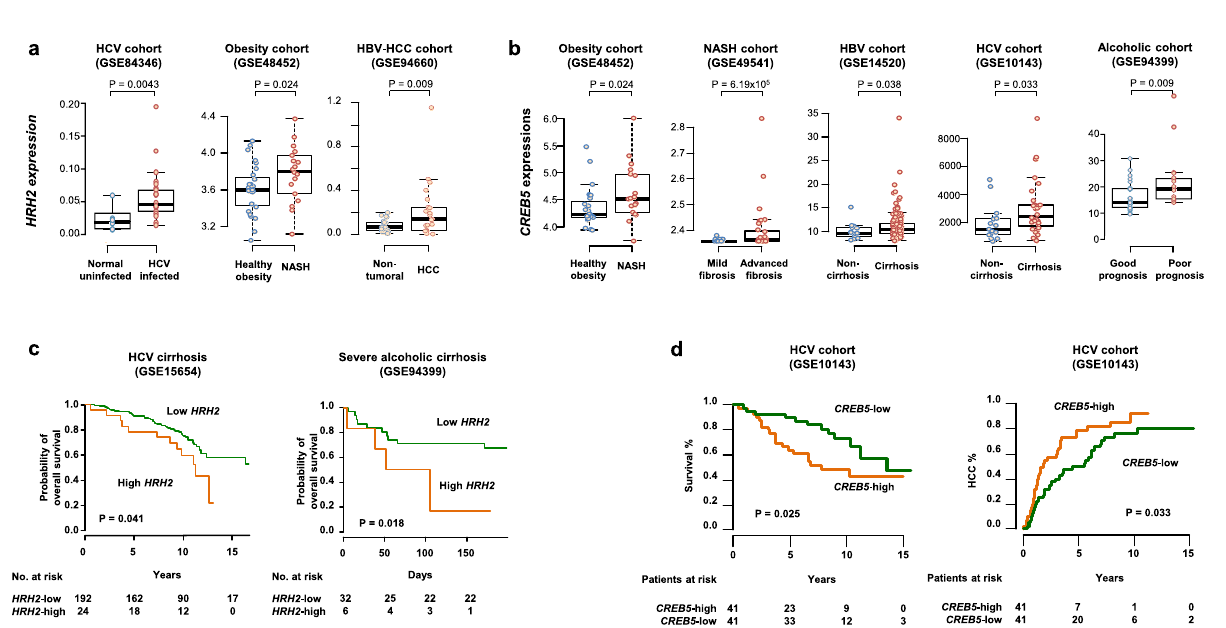
Fig. 7 Expression of the liver HRH2/CREB5 pathway is associated with chronic liver disease progression and hepatocarcinogenesis in patients. a , b HRH2 ( a ) and CREB5 ( b ) expression in liver tissues of clinical cohorts with various liver disease etiologies. In box and whisker plots, boxes represent the 75th and 25th percentiles, the whiskers represent the most extreme data points within interquartile range × 1.5, and the horizontal bar represents the median. Open circle indicates actual observation for each sample. Exact p values are indicated for each panel (Wilcoxon ’ s rank-sum test for all panel excepted for GSE94660, paired Wilcoxon ’ s rank-sum test). GSE84346: normal uninfected, n = 6, HCV infected, n = 40; GSE48452: healthy obesity, n = 27; NASH, n = 18; GSE94660, paired samples, n = 21; GSE48452: healthy obesity, n = 27; NASH, n = 18; GSE49541: mild fi brosis, n = 40, advanced fi brosis, n = 32; GSE14520: non-cirrhosis, n = 14, cirrhosis, n = 185; GSE10143: non-cirrhosis, n = 15, cirrhosis, n = 32. GSE94399: good prognosis, n = 23; poor prognosis, n = 15. c Higher expression of HRH2 in patient liver biopsies is associated with poor-prognosis and decreased probability of overall survival. Exact p values are indicated for each panel (log-rank test for comparisons of Kaplan – Meier survival). d Higher expressions of CREB5 in the adjacent livers were signi fi cantly associated with decreased survival and tumor recurrence after curative resection among patients with HCC. Exact p values are indicated for each panel (log-rank test for comparisons of Kaplan – Meier survival). Source data are provided as a Source data fi